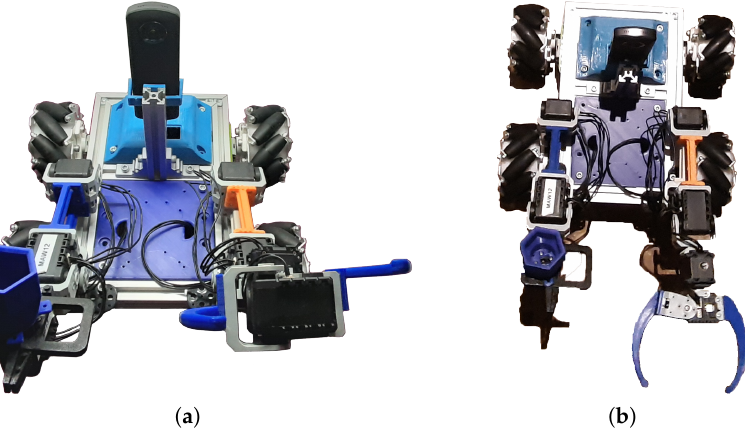
Figure 26. MiniCernBot reconfigured to have dual-arms, omnidirectional wheels, multipurpose right-hand, and 360 ◦ camera. ( a ) Frontal view, ( b ) top view